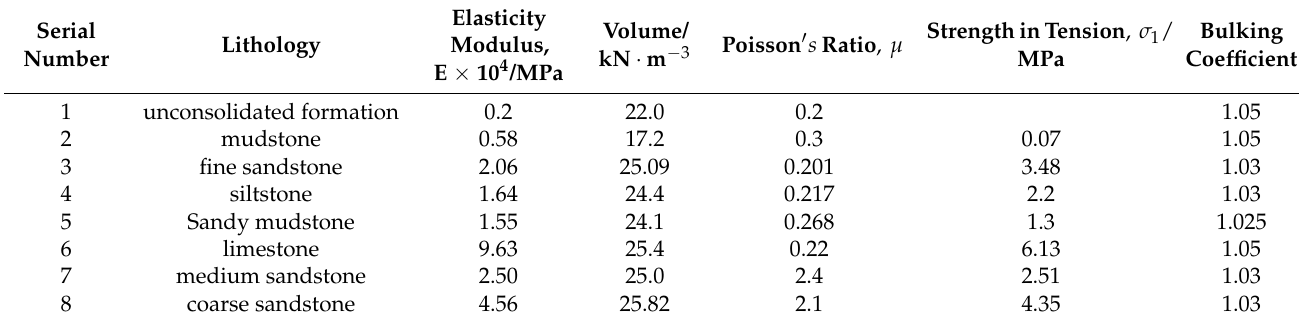
Table 1. Rock mechanical parameters.